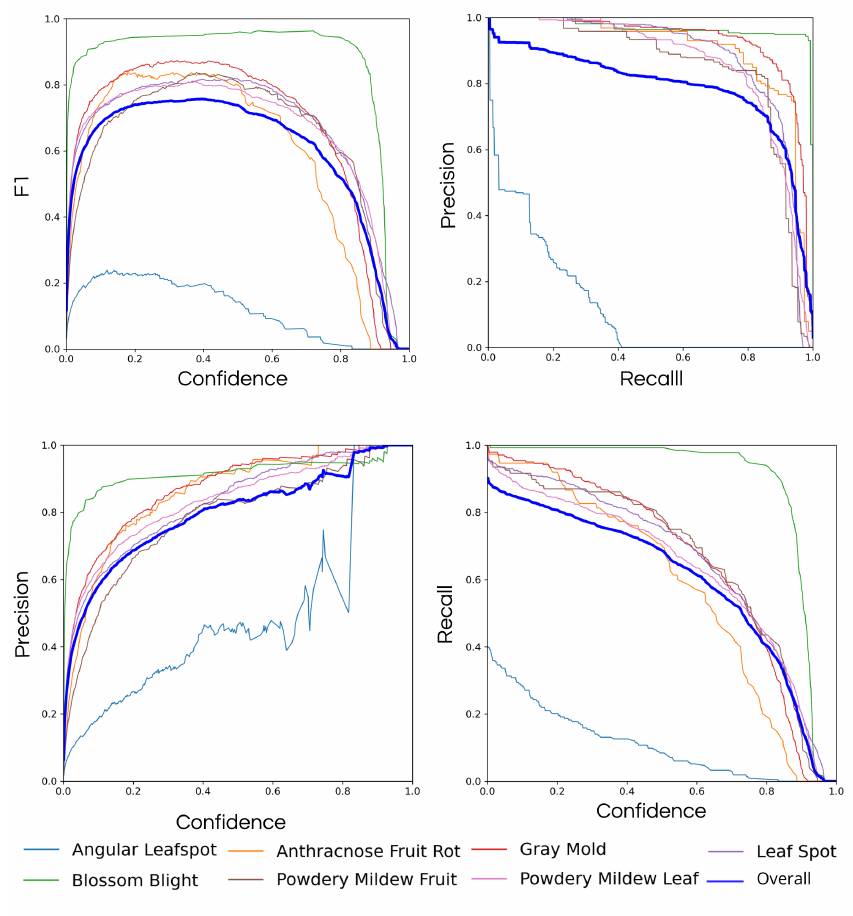
Figure 20. Model performance on the test set.